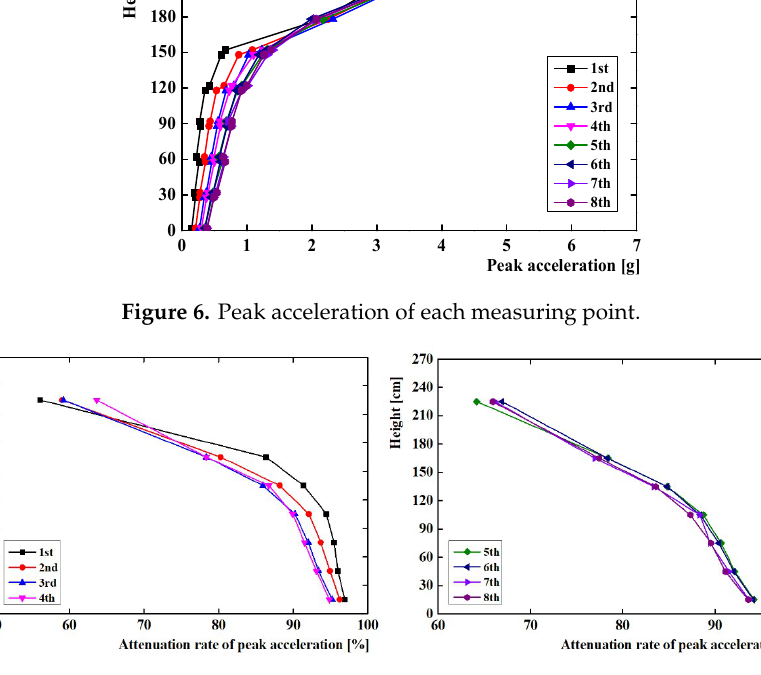
Figure 7. Peak attenuation rate of acceleration of each measuring point.